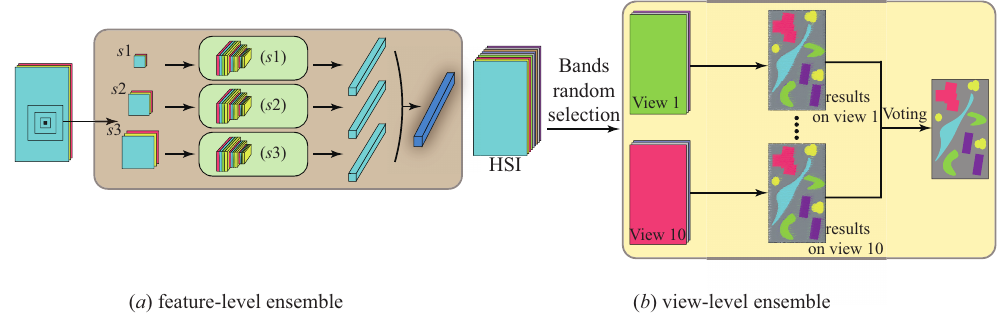
Figure 4. Illustrations of the proposed ensemble strategies.